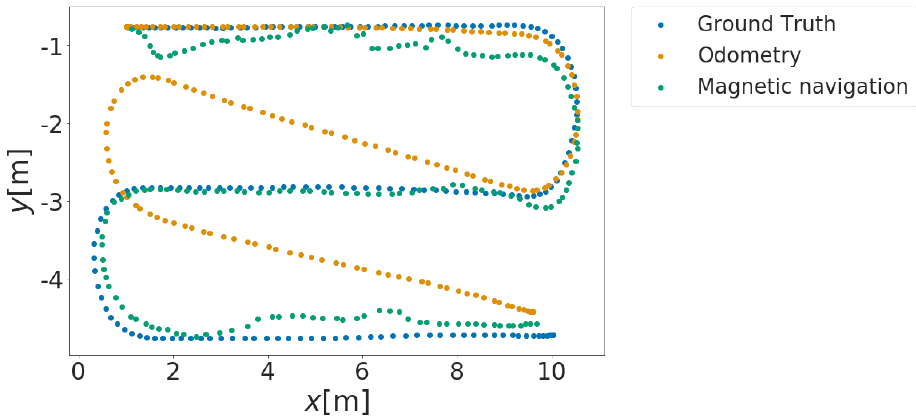
Figure 6. Example of localization result. Compare the results of odometry-only localization and magnetic navigation method localization for the specified path indicated by the blue dots with those indicated by the yellow and green